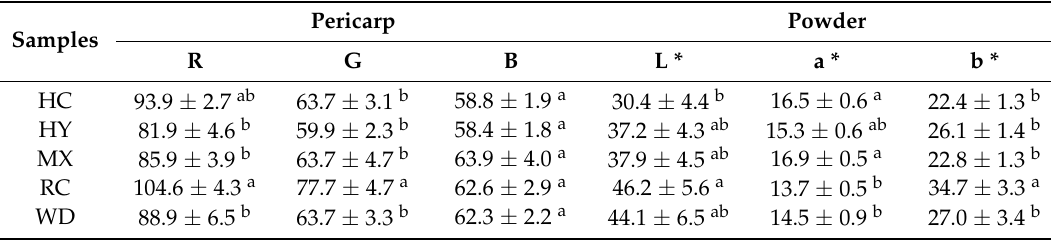
Table 1. Color parameters of red pepper pericarp and powder from different origins.